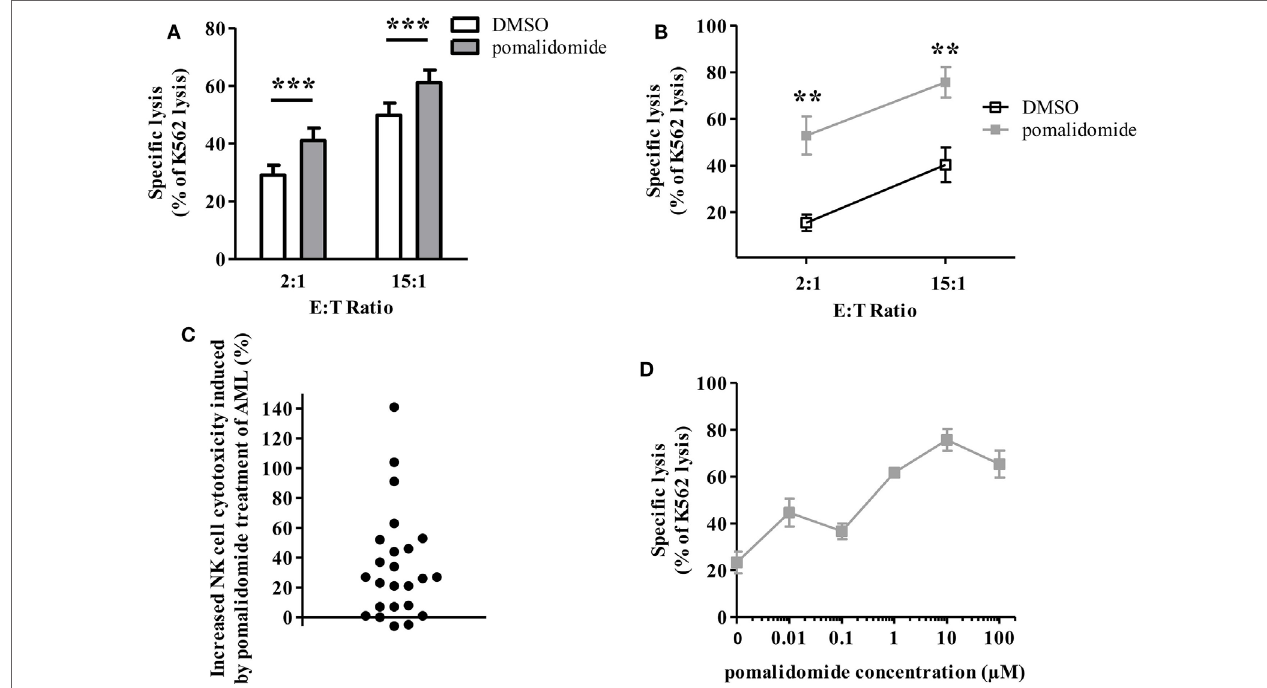
FigUre 2 | Pomalidomide sensitizes acute myeloid leukemia (AML) blasts to natural killer (NK) cell lysis. Primary AML blasts were pre-incubated for 48 h with pomalidomide (10 µM) or DMSO. They were extensively washed before the addition of allogeneic NK cells from healthy volunteers (HV). Standard [51Cr]-release assay was used to evaluate specific lysis by NK cells. Results were presented normalized to K562 lysis. (a) Comparison of the sensitivity of AML blasts ( n = 24) after treatment with pomalidomide or DMSO to allogeneic NK cells ( n = 2–12). Data are shown for E:T 2:1 and 15:1. (B) Representative data from one experiment: primary AML blasts (from patient upn20) lysis by NK cells from HV ( n = 10). (c) For each AML patient ( n = 24), the cytotoxicity by NK cells from healthy volunteers ( n = 3–12) at E:T ratio 15:1 in the pomalidomide condition was evaluated relatively to the DMSO condition and represented as percent of increase of cytotoxicity. For each patients, the mean of [(specific lysis of AML treated by pomalidomide—specific lysis of AML treated by DMSO)/specific lysis of AML treated by DMSO] was represented. (D) Dose-response effect of pomalidomide on enhancement of AML blasts lysis by allogeneic NK cells ( n = 3). Primary AML blasts from one patient were pre-incubated with 10-fold dilutions of pomalidomide starting from 100 µM, or DMSO as the control treatment. Results are expressed as mean ± SEM and statistical significance was established using paired Student’s t -test (a) and Wilcoxon matched pairs test (B)